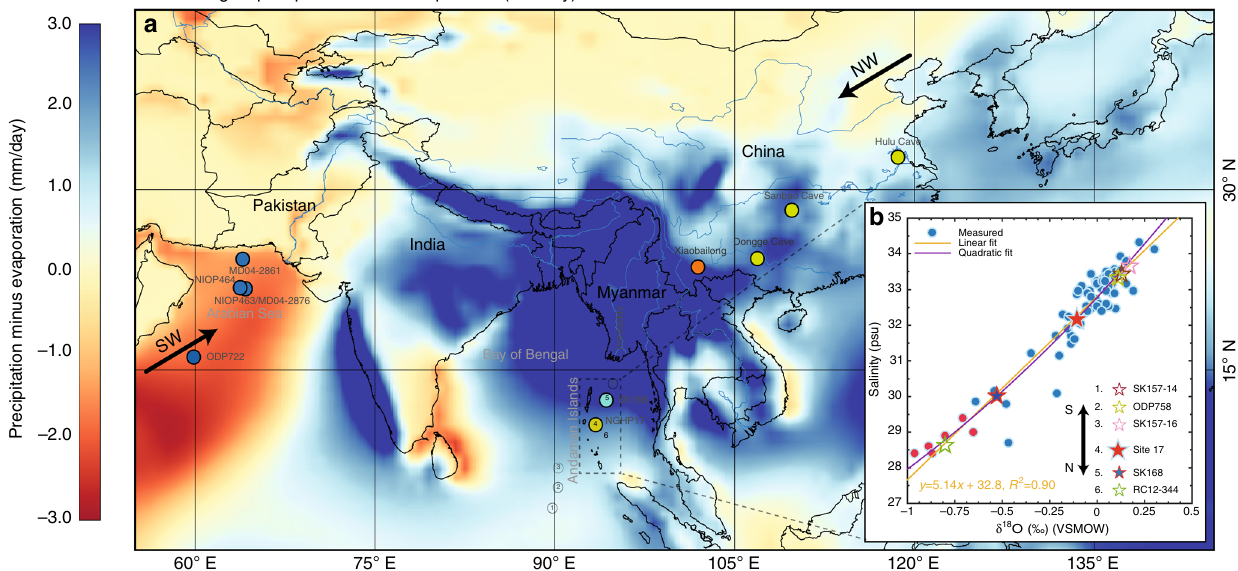
Fig. 1 Summer net precipitation in the Asian monsoon domain and modern day salinity and δ 18 Osw measurements. a Precipitation minus evaporation (mm/day) in the Asian monsoon domain for the period 1979 – 2015 (precipitation and evaporation data from ERA-Interim global reanalysis dataset). Andaman Sea core sites NGHP 17 (ref. 27 ) and SSK 168 (refs. 28,29 ) are shown in yellow and dark green- fi lled circles. Filled circles show cave and core locations from mainland China 15,19 , the Arabian Sea 9,10 and the equatorial eastern Indian Ocean (ODP758) 13 . b Paired δ 18 Osw and salinity measurements from surface water samples collected from the Andaman Islands in 2011 and 2013 (see Methods) and estimates of δ 18 Osw calculated based on planktic foramifera late Holocene (0 – 2 kyrs) δ 18 O values and modern day mean annual SST 50 (see Methods for δ 18 O – temperature calibration equation) for six core locations along the N-S transect shown in black circles with numbers (see legend). Measured δ 18 Osw values shown in red- fi lled circles are from